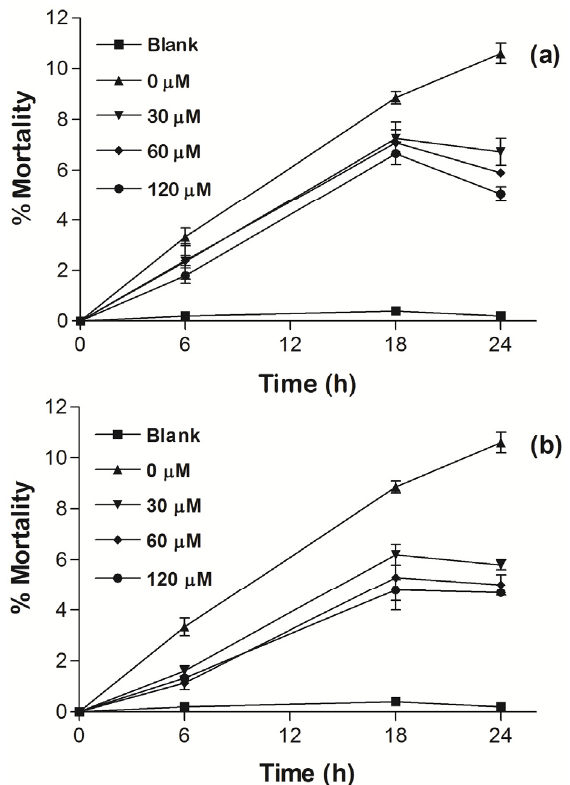
Figure 10. Cellular protection of ( a ) Fe damage by ROS. The line marked as blank corresponds to PBMCs in RPMI medium with no treatment. Data comes from a representative experiment. Points represent the standard error of the mean (±SEM) of triplicate